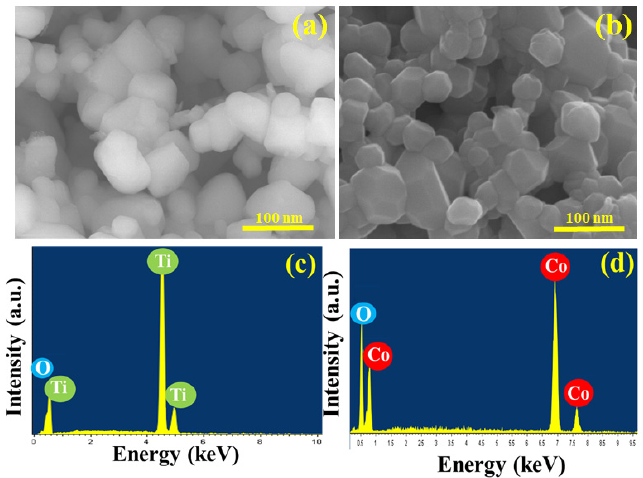
Figure 4. FE-SEM images of ( a ) Li 2 TiO 3 , and ( b ) LiCoO 2 ; EDAX pattern of ( c ) Li 2 TiO 3 , and ( d ) LiCoO 2 .